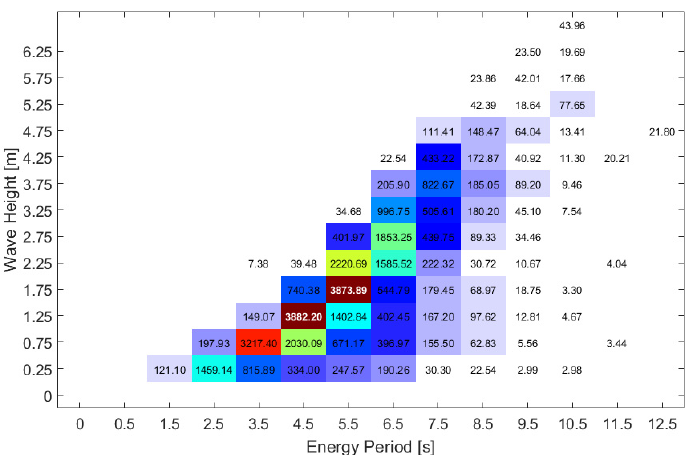
Figure 13. Scatter diagram on the annual energy distribution of the WEC under optimal control. The energy in each square corresponds to the sea state of Site 1.